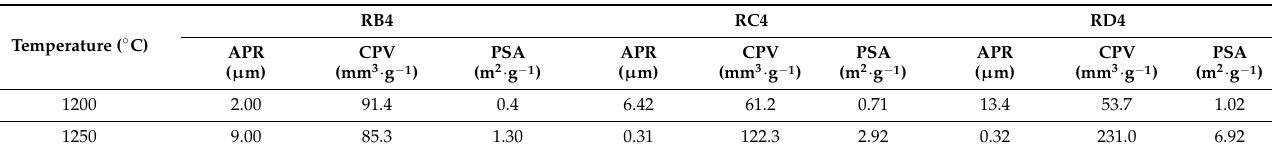
Table 2. Average pore radius and pore surface area of the refractory geopolymer composites with 85 wt.% kyanite aggregates at 1200 and 1250 ◦ C.